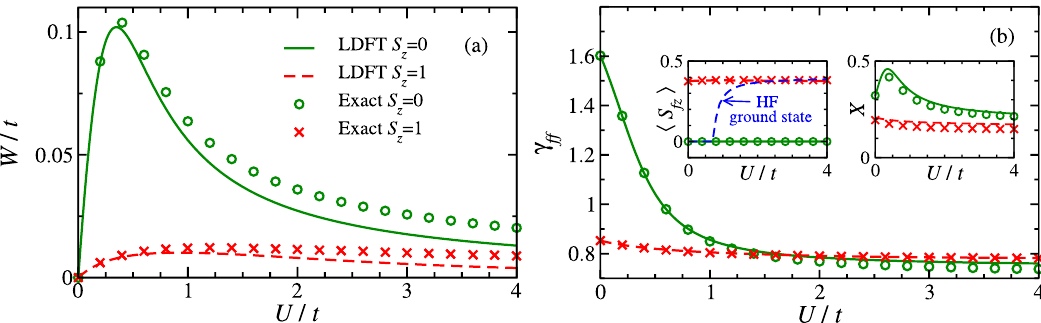
Figure 2. Ground-state and triplet-state properties of Anderson rings having N o = 12 orbitals and N = 12 electrons as a function of the Coulomb-repulsion strength U / t at the impurity orbital: ( a ) interaction energy W ; and ( b ) impurity occupation γ f f . The insets in ( b ) show the impurity ˆ S spin polarization fz (cid:105) and the degree of charge fluctuations X . Lattice density-functional theory (cid:104) (LDFT) results obtained within the two-level approximation (TLA) W 2L (solid and dashed curves) are compared with exact Lanczos diagonalizations (symbols) for ε f = 0 and V sf / t = 0.4. In the inset of ˆ S ( b ) the unrestricted Hartree–Fock results for fz (cid:105) are given by the dashed blue curve for the sake of (cid:104) comparison. Reproduced with permission from References [71,77]. c (cid:13) American Physical